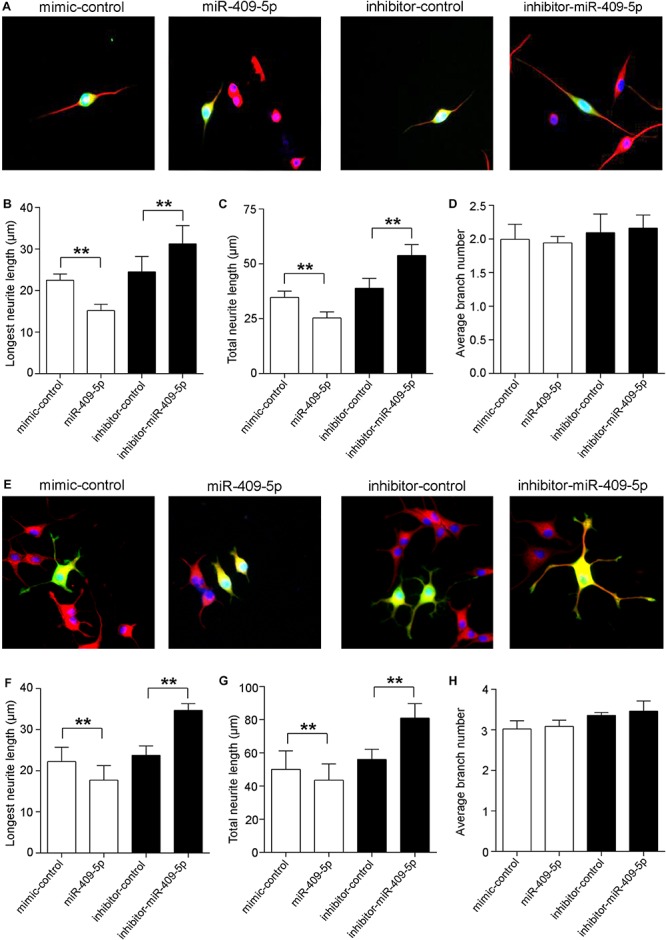
MiR-409-5p slightly aggravated the insult of Aβ1–42 on neurite growth and branching in neuronal-like cell lines. Neuro2A (A–D) or PC12 (E–H) cells were transfected with PEGFP-C2 (0.5 μg) and miR-409-5p mimic (100 nM) or inhibitor (100 nM). After 3 days, cells were fixed and immunostained with anti-β-tubulin III antibody. The longest neurite length, total neurite length, and branch numbers were quantified of by ImageJ software. The results were shown as the mean ± SD (∗∗p < 0.01). The experiment was repeated independently for three times. Red, β-tubulin III; Green, GFP; Yellow, merged. Unpaired t-test was used to analyze differences.